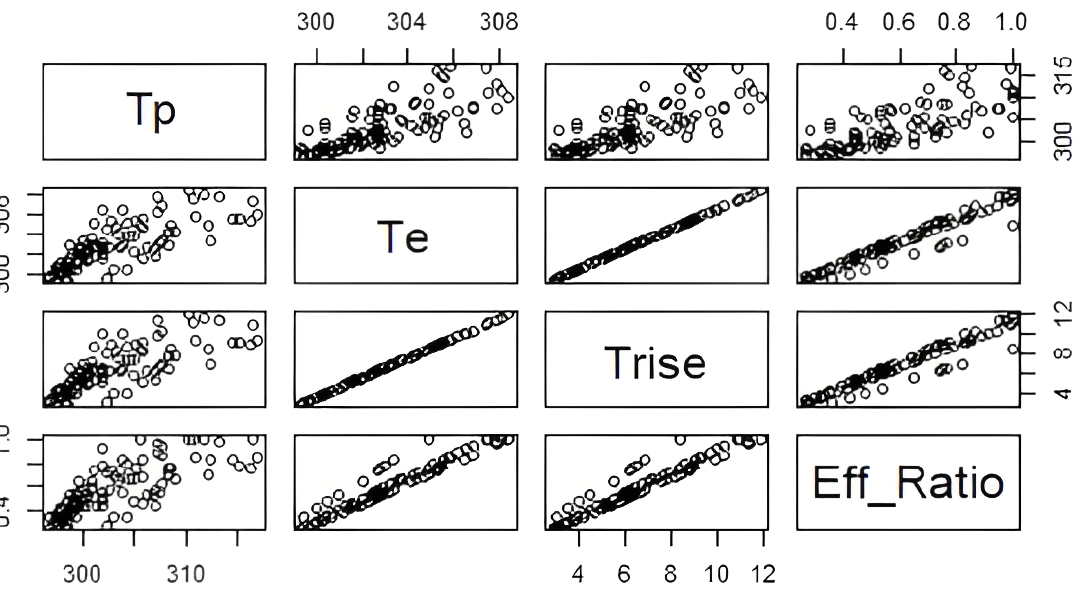
Figure 7. Relationship among T p , T e , T rise, and efficiency/maximum efficiency (Eff) ratio in a flat UTC.